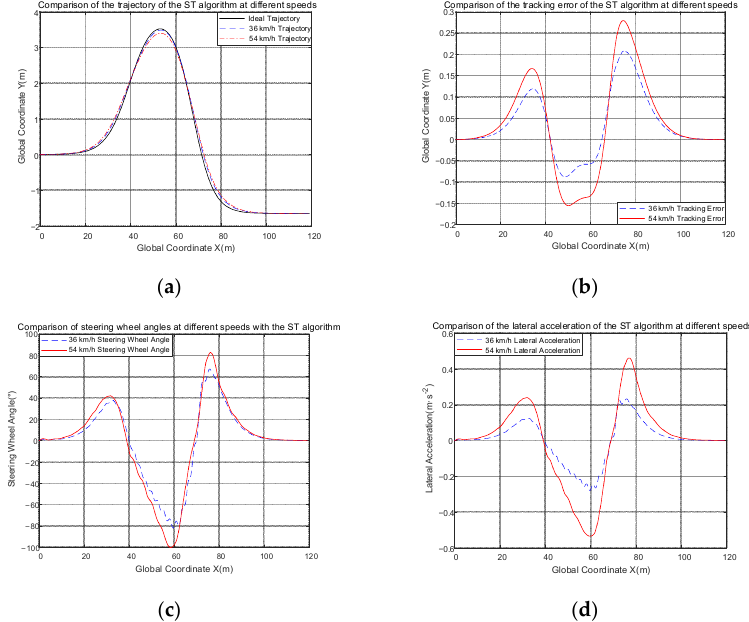
Figure 8. Comparison of different parameters at different speeds. ( a ) Comparison of trajectories at different speeds; ( b ) comparison of tracking error at different speeds; ( c ) comparison of steering angle at different speeds; ( d ) comparison of lateral acceleration at different speeds.